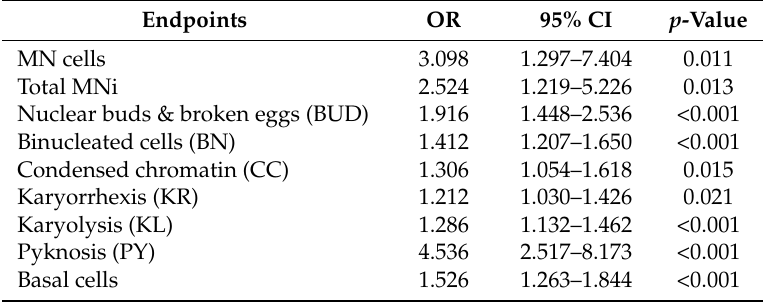
Figure 2. Means and 95% confidence intervals of nuclear anomalies in buccal cells from non-exposed workers (light bars) and pesticide-exposed workers (dark bars). MN cells to BUD: left axis, BN to BASAL: right axis. * p < 0.05, ** p < 0.01; MN cells: number of micronucleated cells; Total MNi: total number of micronuclei; BUD: nuclear buds & broken eggs; BN: binucleated cells; CC: condensed chromatin; KR: karyorrhexis; KL: karyolysis; PY: pyknosis; BASAL: basal cells. Table 2. Odds ratio and 95% confidence intervals for nuclear anomalies in pesticide workers relative to controls corrected for age, BMI, tobacco chewing, smoking, and alcohol consumption. Endpoints OR 95% CI